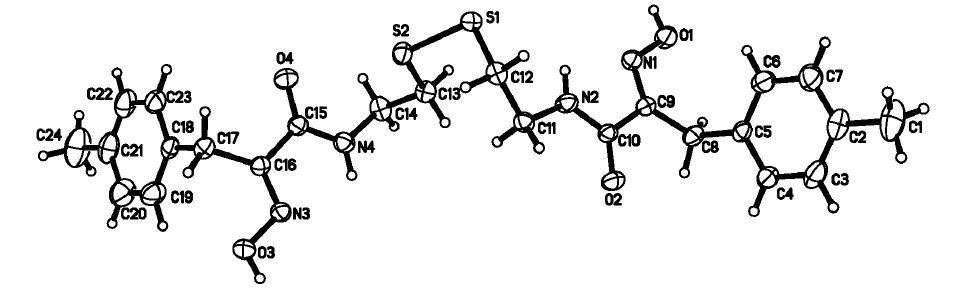
Figure 2. The molecular structure of the compound 8b with 30% probability of thermal